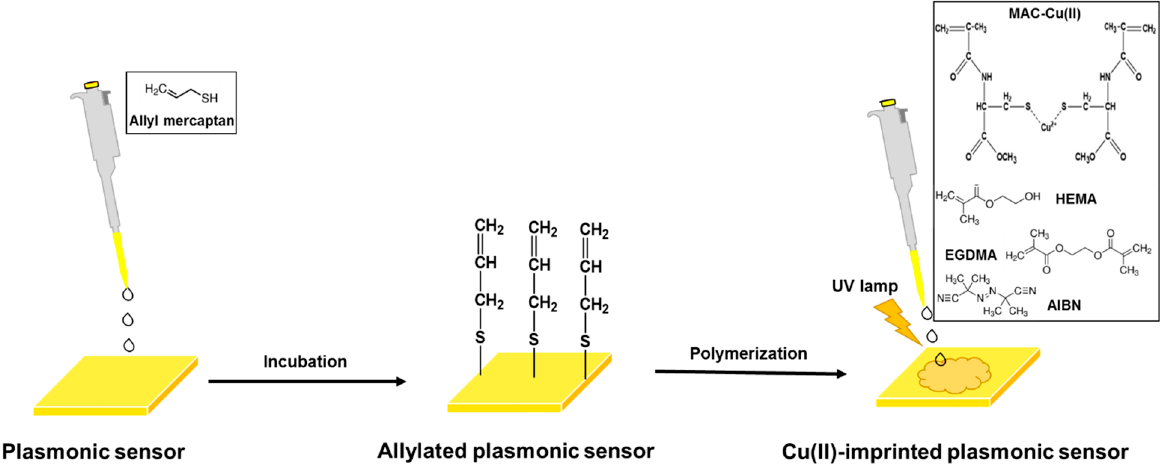
Figure 1. Schematic representation of plasmonic sensor preparation.